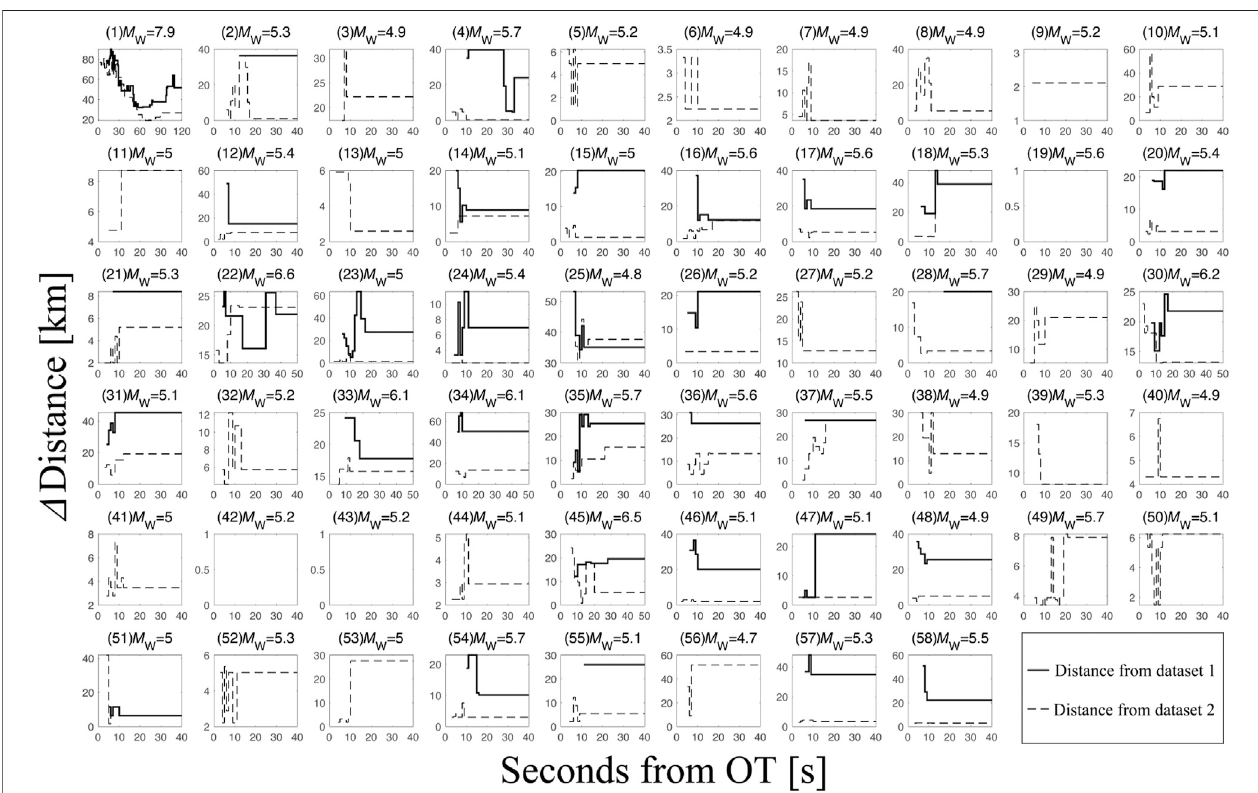
FIGURE 10 | Temporal evolution of the distance between the FinDer centroid and the reported epicenter (for M W < 6)/centroid (for M W ≥ 6) from event origin time (OT) for all 58 earthquakes (neglecting data latencies).